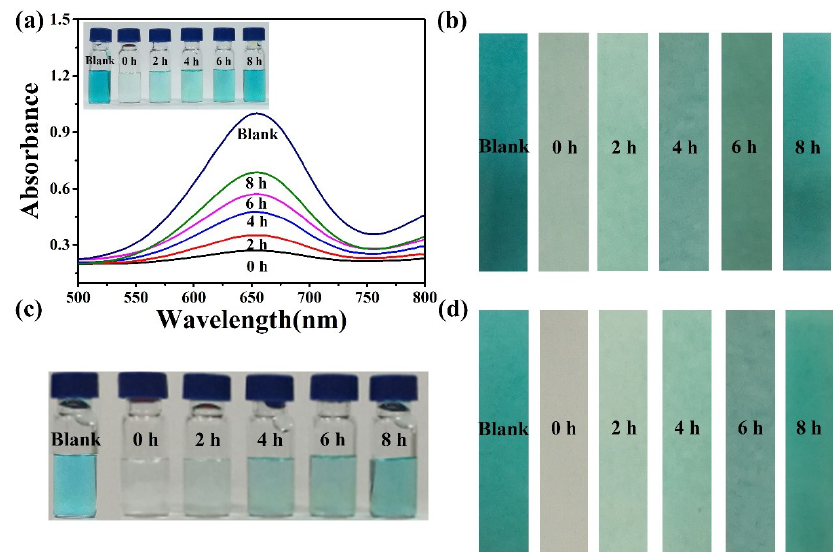
Figure 5. ( a ) Absorption spectra (inset is digital photo) of Ag + -TMB sensing system and ( b ) test papers toward oleic acid samples with heat treatment at 180 °C for different times; ( c ) digital photo of Ag + -TMB sensing system and ( d ) test papers toward hot pot oils with heat treatment at 180 °C for different time.